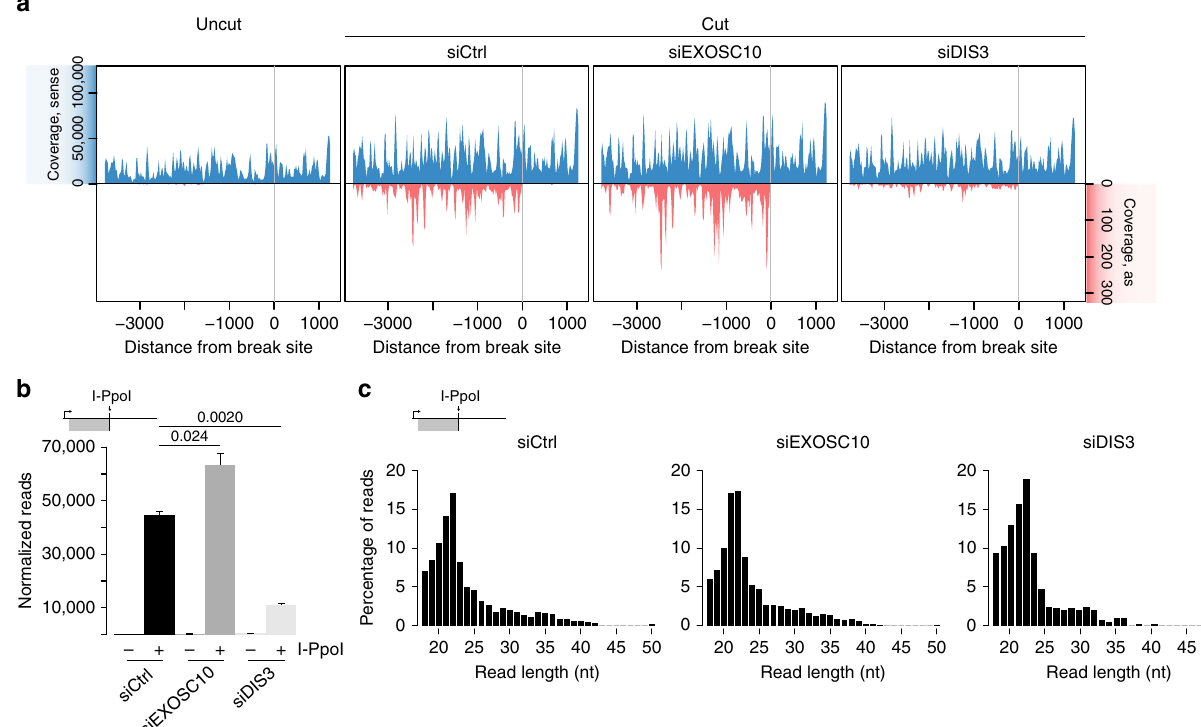
Fig. 5 Exosome depletion affects diRNA levels but not diRNA processing. a HeLa cells were transfected with control siRNA, siEXOSC10, or siDIS3 and the pOPRSVI/MCS-I-PpoI plasmid for I-PpoI expression. Total RNA was puri fi ed 36 h after I-PpoI transfection and the small RNA fraction was isolated and sequenced. The plots show the coverage pro fi le of small RNAs that map to the 28S rRNA locus normalized to spike-in RNAs in non-transfected cells ( uncut ) and transfected cells ( cut ). The x -axis indicates the distance from the I-PpoI cleavage site. b The graph shows the number of collapsed reads normalized to spike-ins that appear at the upstream antisense region of the I-PpoI DSB. The error bars show s.d. Changes in read counts in siEXOSC10 and siDIS3 compared to control siRNA are statistically signi fi cant using a paired two-tailed Student ’ s t -test ( n = 3). c Read length distribution based on the percentage of upstream antisense reads in the three different conditions control siRNA, siEXOSC10 and siDIS3, as indicated. Source data for Fig. 5a – c are provided as a Source Data fi